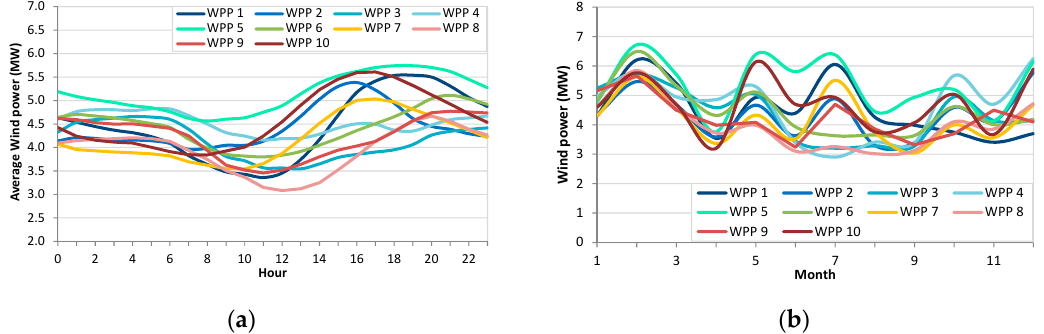
Figure 5. Average ( a ) daily and ( b ) monthly wind power profiles for all ten WPPs identified with the clustering approach.